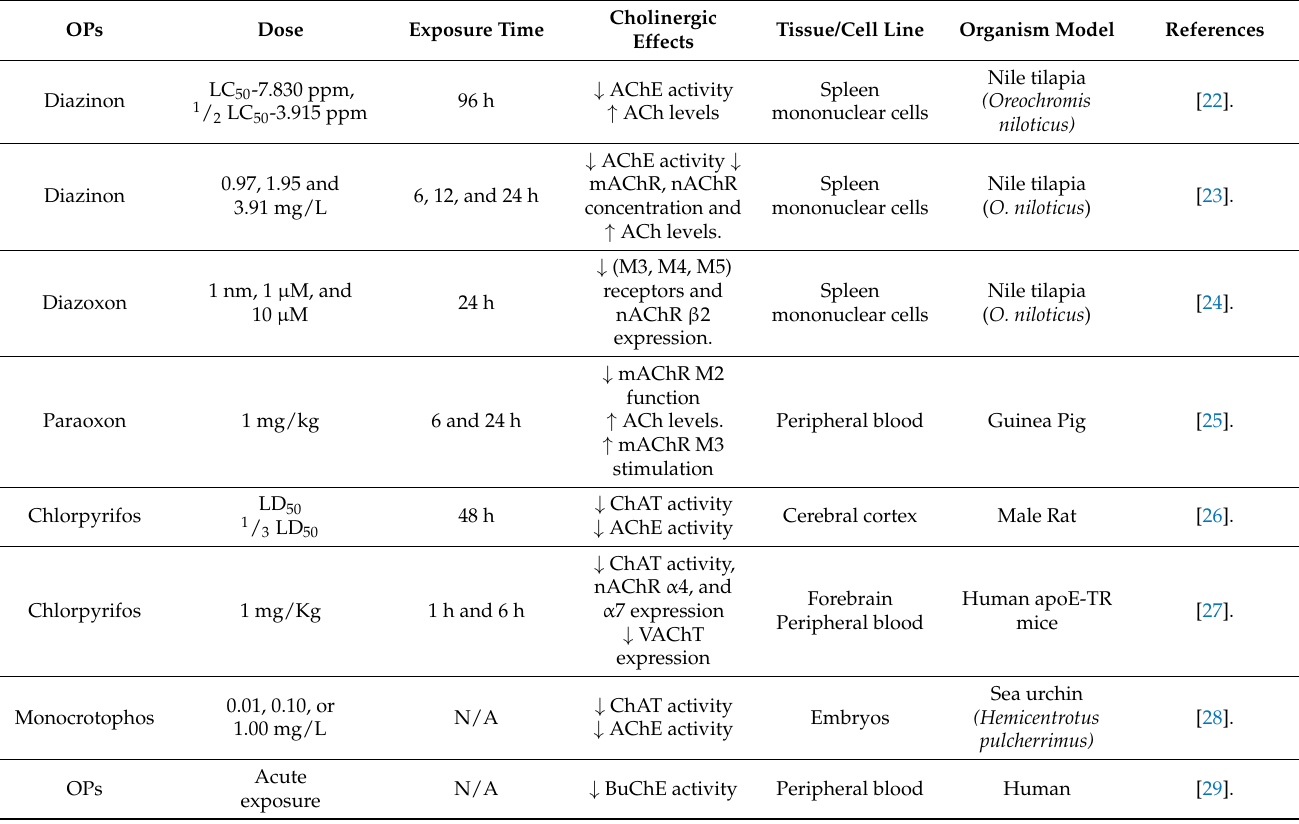
Table 1. Effects on cholinergic systems by OP